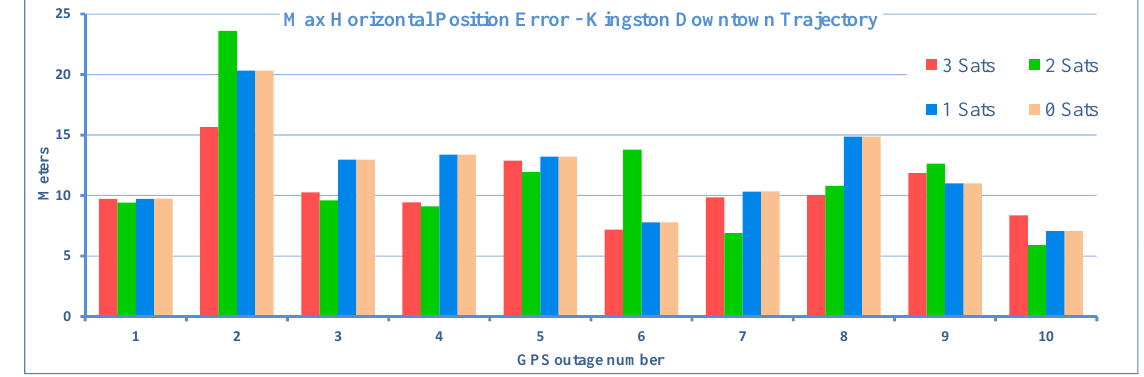
Figure 7. Maximum 2D positional errors for GPS outages of the Kingston downtown trajectory.